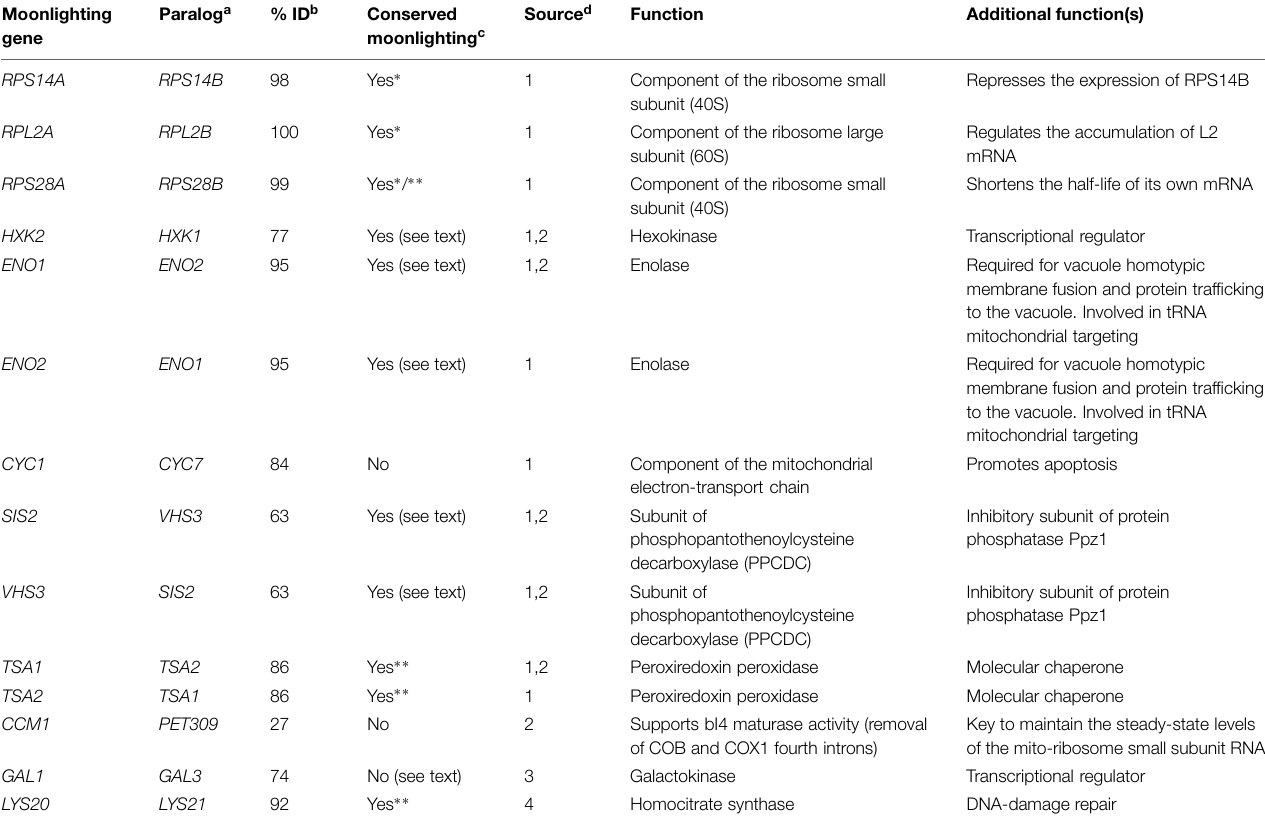
TABLE 1 | Moonlighting paralogs in Saccharomyces cerevisiae . Moonlighting